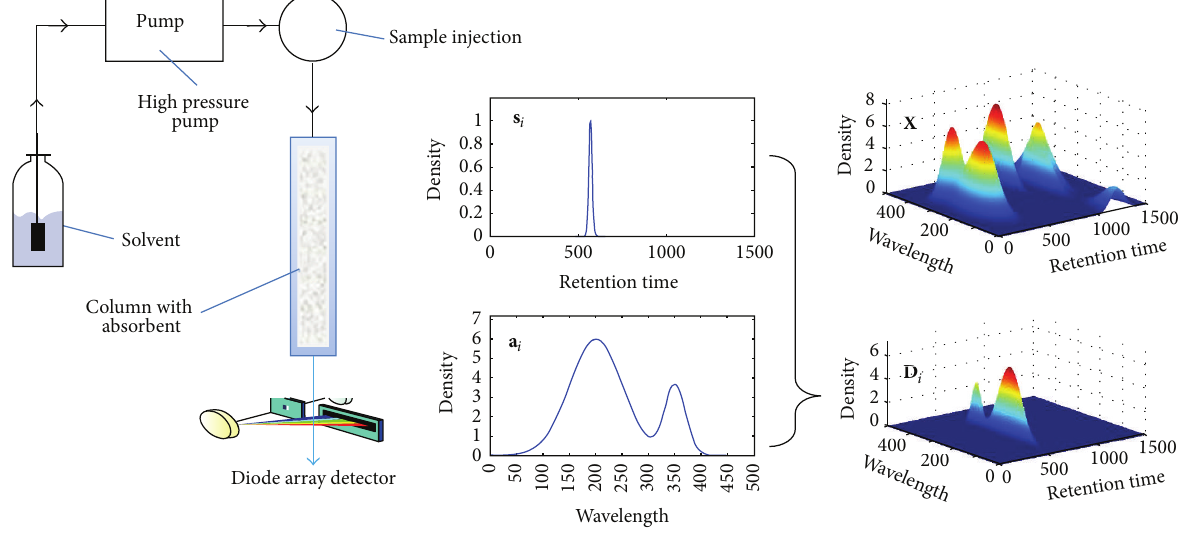
Figure 1: The principle of the HPLC-DAD data